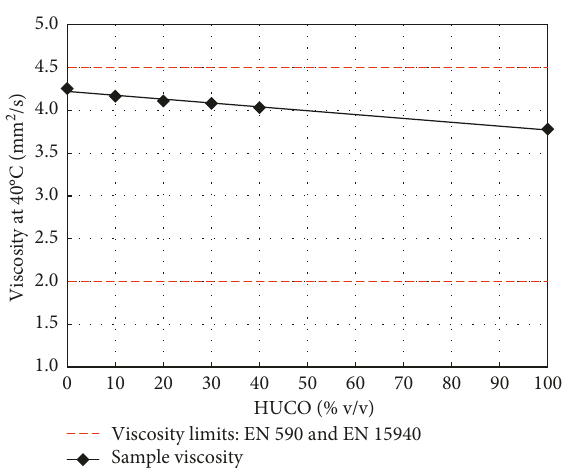
Figure 4: Viscosity at 40 ° C of ULSD, HUCO, and their blends, measured by ASTM D7042 standard test